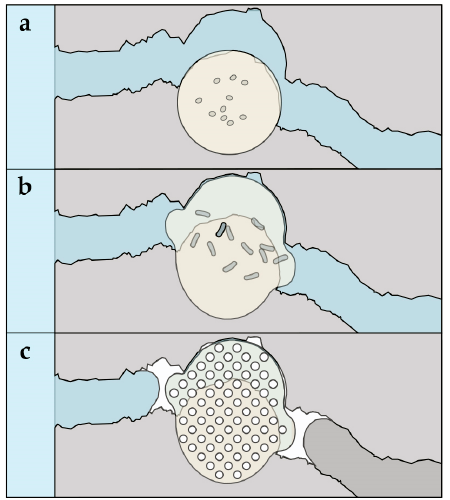
Figure 1. Schematic diagram illustrating the proposed healing mechanism: ( a ) in the event of cracking and water ingress; ( b ) the bacteria ‐ based beads incorporated in the composite will swell, this swelling will clog the cracks, and concomitantly “free up” the bacteria, yeast extract and magnesium acetate contained in the beads; ( c ) the magnesium will precipitate as magnesium ‐ based minerals, the spores will germinate as a result of being exposed to the solubilized yeast extract, and metabolize the acetate, inducing calcium ‐ based mineral precipitation in and on the surface of the beads, healing the crack.